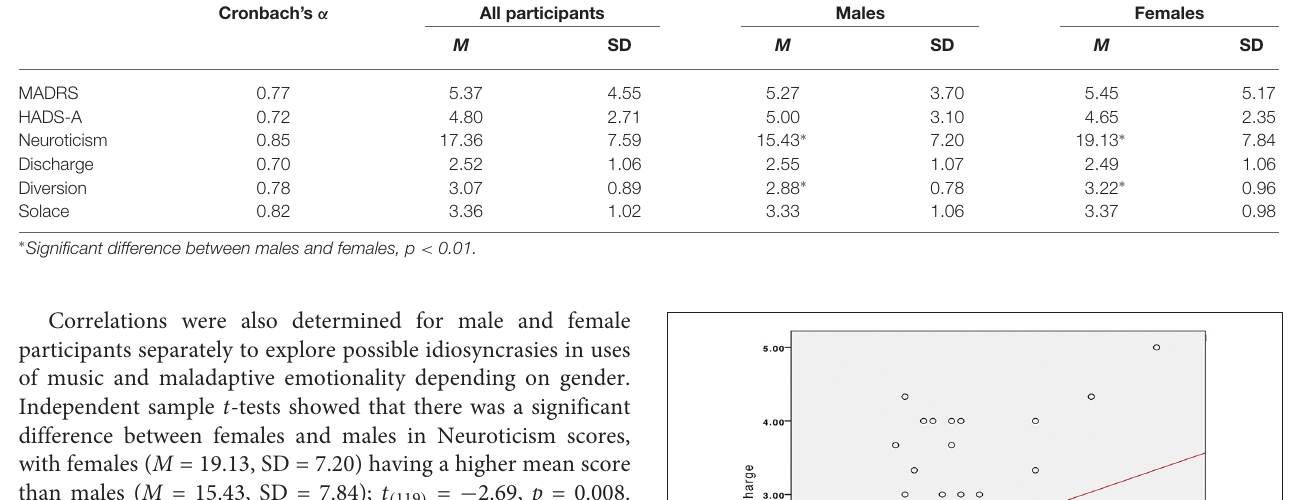
TABLE 2 | Test results for all participants ( n = 123), males ( n = 55) and females ( n = 68). Cronbach’s α All participants Males